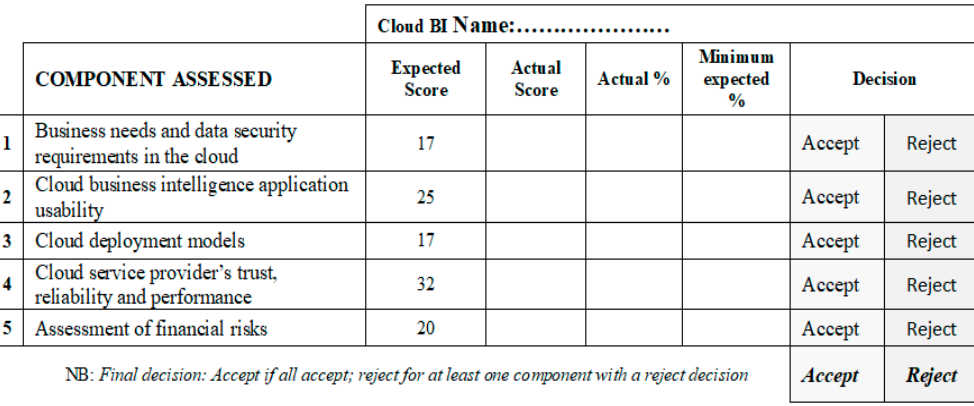
Figure 13. A summary sheet for each set of evaluations.